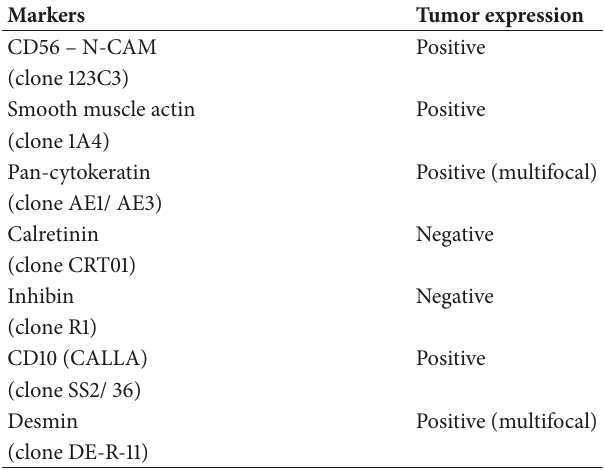
Table 1: Immunohistochemical analysis revealing a uterine tumor resembling ovarian sex-cord tumors (UTROSCT), Hospital